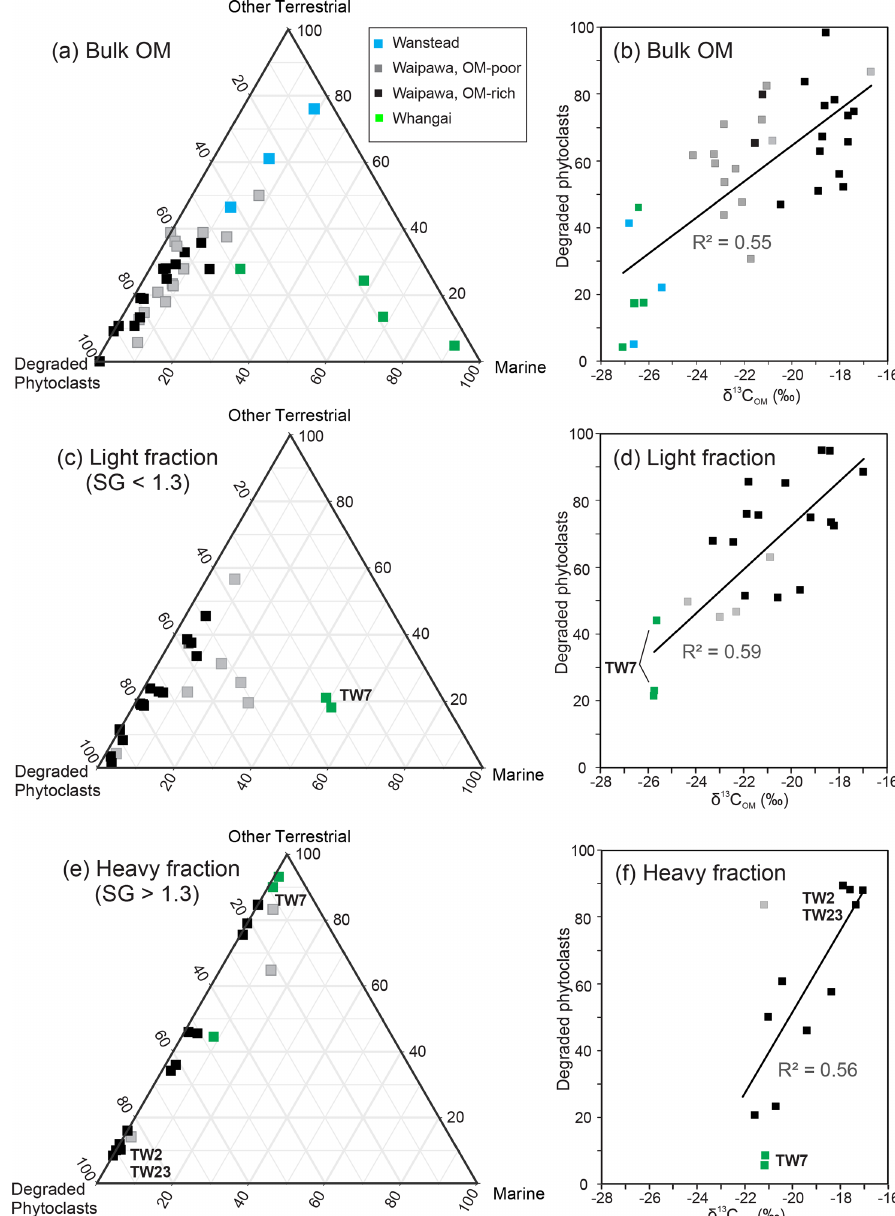
Figure 5. Proportions of primary palynofacies components (degraded phytoclasts, other terrestrial, marine) in (a) bulk organic matter and (c) light and (e) heavy density fractions compared with cross-plots of degraded phytoclasts and δ 13 C OM for (b) bulk organic matter and (d) light and (f) heavy density fractions for samples from four facies in the Taylor White section. Selected samples referred to in text are annotated. Density fractions were unavailable for Wanstead and some Whangai samples because of low OM